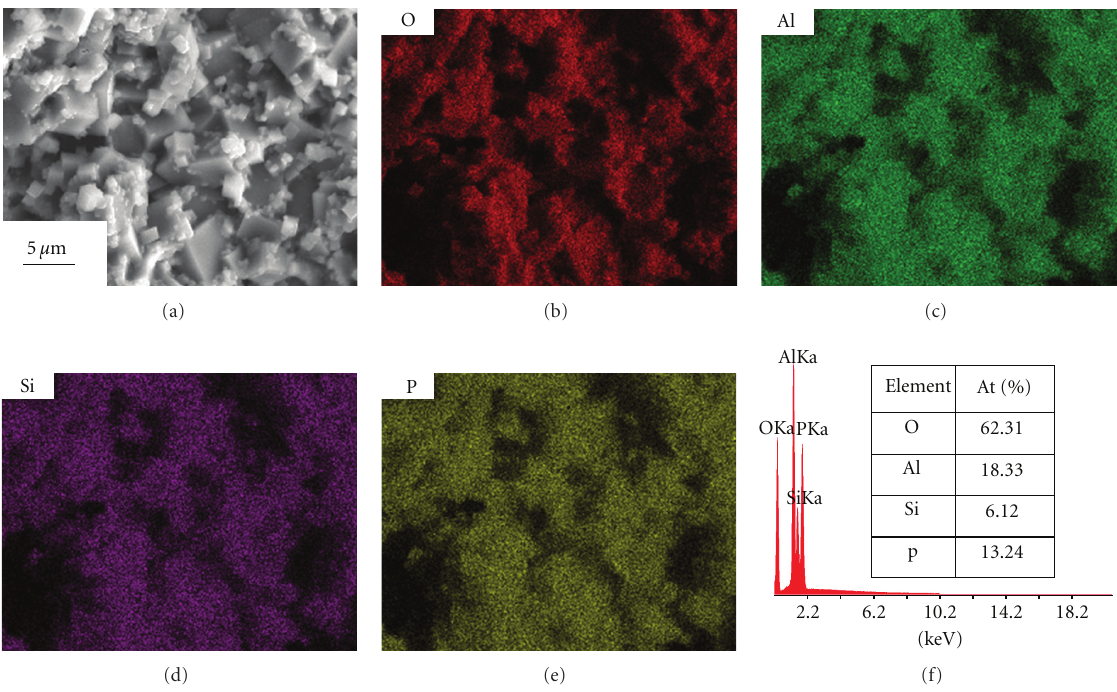
Figure 6: (a) FESEM micrograph of SAPO 34 membrane, and (b–e) represent the elemental mapping (O, Al, Si, and P) of the developed membrane and (f) corresponding EDAX spectra of the membrane layer along with atomic